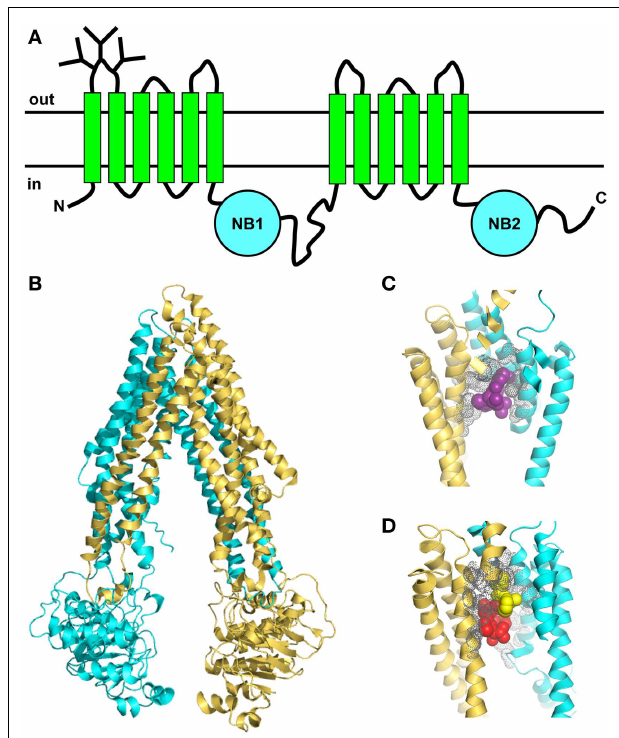
FIGURE 3 |Topology and X-ray crystal structures of Pgp . (A) The membrane topology shows two homologous halves, each with sixTM segments and a NB domain on the cytoplasmic side, which binds and hydrolyzes ATP. (B) X-ray crystal structure of mouse Pgp (34) shows an inward-facing conformation in the absence of nucleotide (PDB 3G61). (C,D) The drug-binding pocket of mouse Pgp as seen in the X-ray crystal structure. (C) Close-up view (4.4 Å resolution) of one molecule of the cyclic peptide modulator QZ59-RRR (magenta, space-filling format) occupying the middle site inside the drug-binding pocket, with the volumes of nearby side-chains shown in gray (PDB 3G60). (D) Close-up view of two molecules of the cyclic peptide modulator QZ59-SSS occupying the upper and lower sites (yellow and red, respectively, space-filling format) inside the drug-binding pocket, with the volumes of nearby side-chains shown in gray (PDB